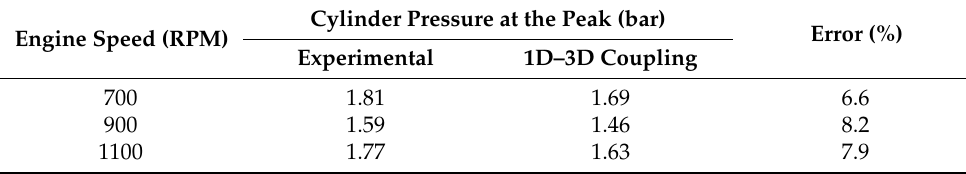
Figure 4. Cylinder pressure results in the process of opening the exhaust valve. Table 2. Cylinder pressure results at the peak according to the engine speed.